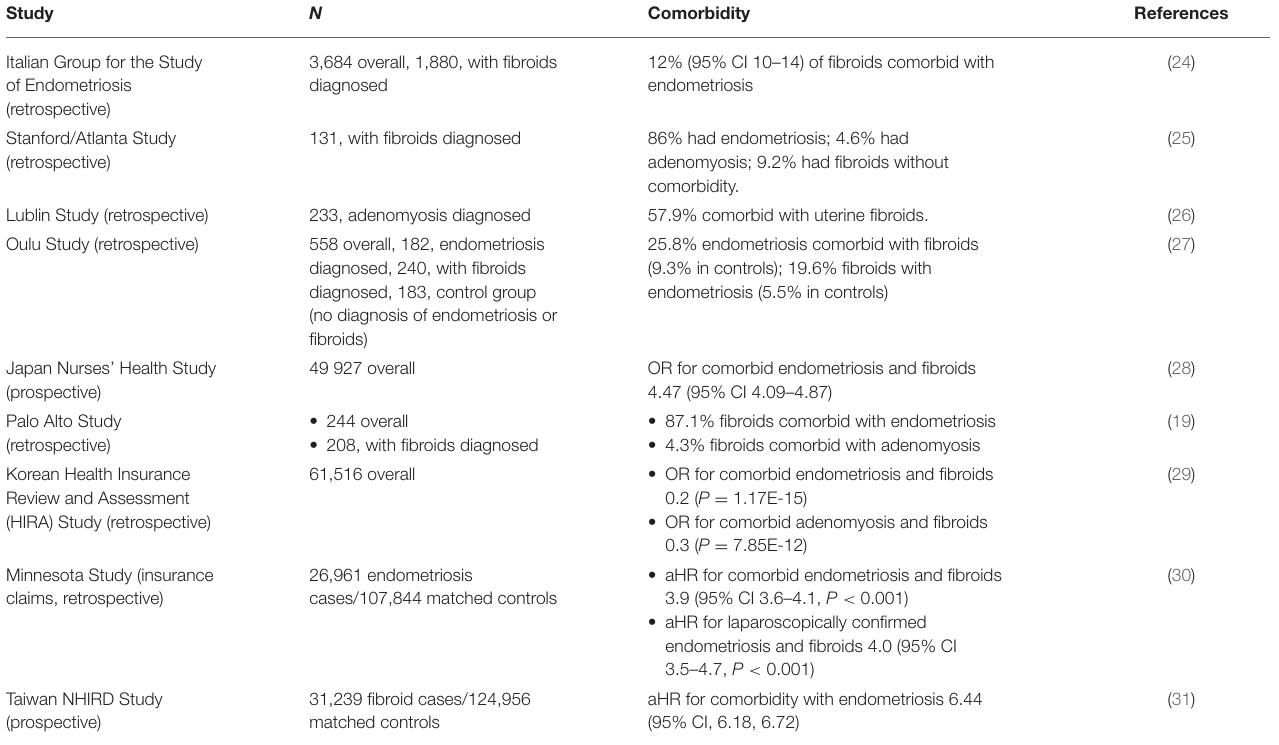
TABLE 1 | Comorbidity of endometriosis and uterine fibroids.